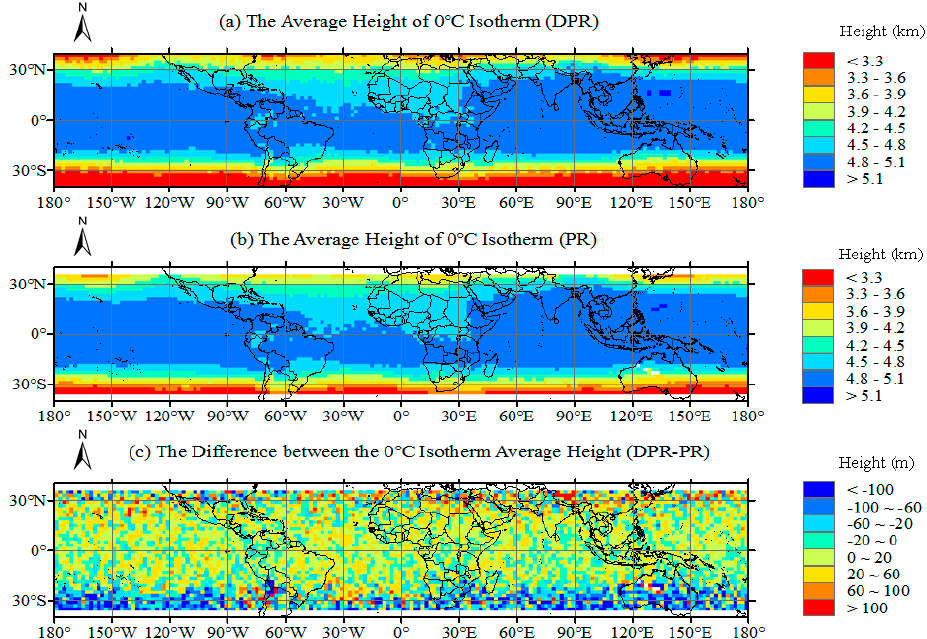
Figure 5. The distribution of the average height of freezing level captured by: ( a ) GPM DPR; and ( b ) TRMM PR. The difference between the observations of the freezing level height is shown in ( c ), calculated by GPM DPR’s observation minus TRMM PR’s. All data are resampled to a spatial resolution of 2° × 2°.